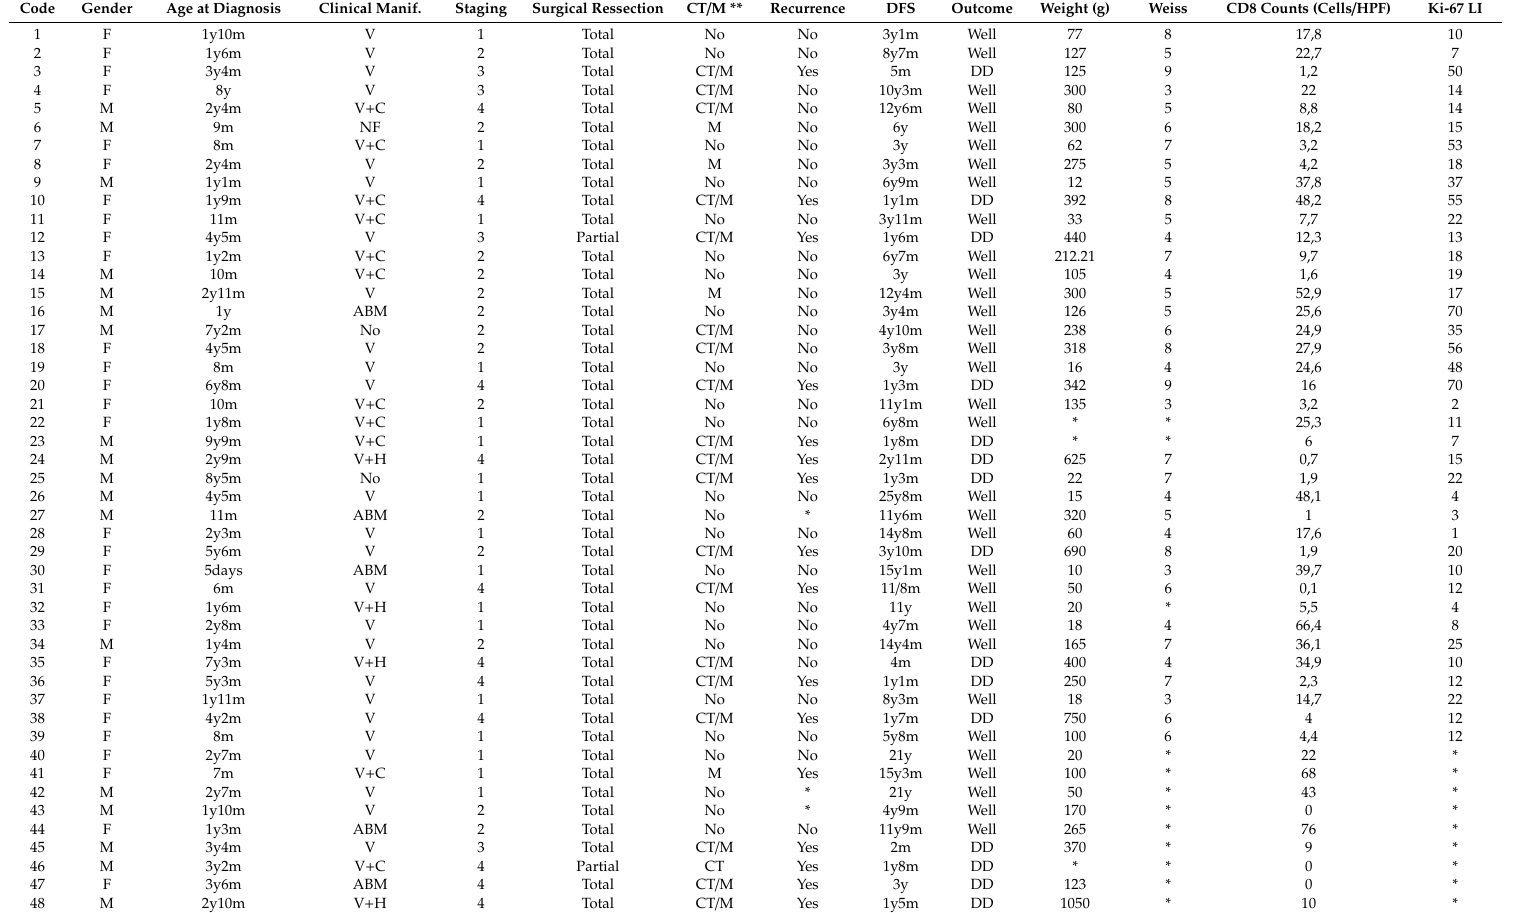
Table 1. Clinical and adrenocortical carcinomas (ACC) histological